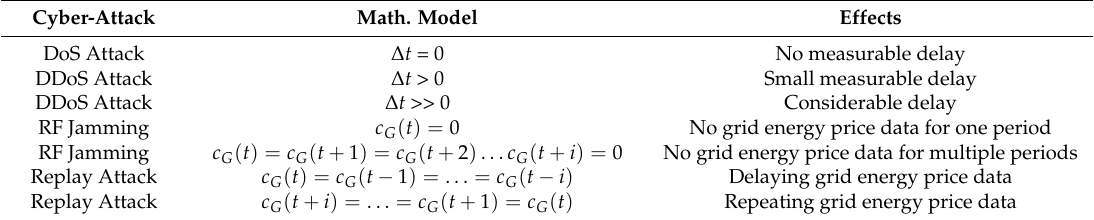
Table 3. Mathematical models for the simulation of availability